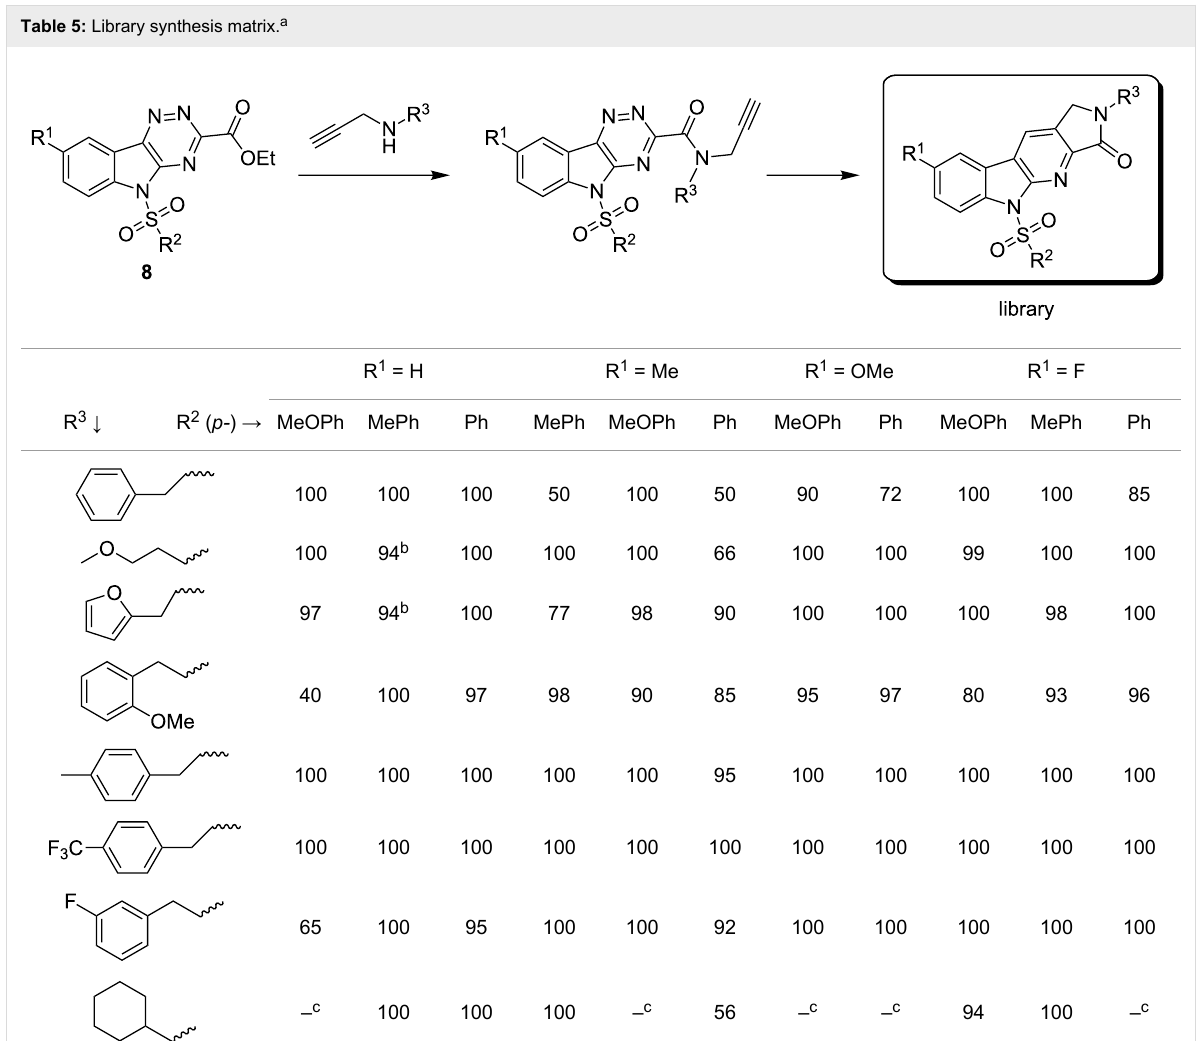
Table 5: Library synthesis matrix. a